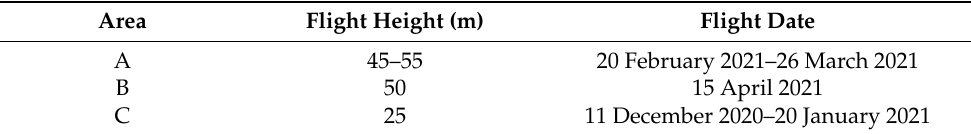
Figure 2. The DJI P4 Multispectral.